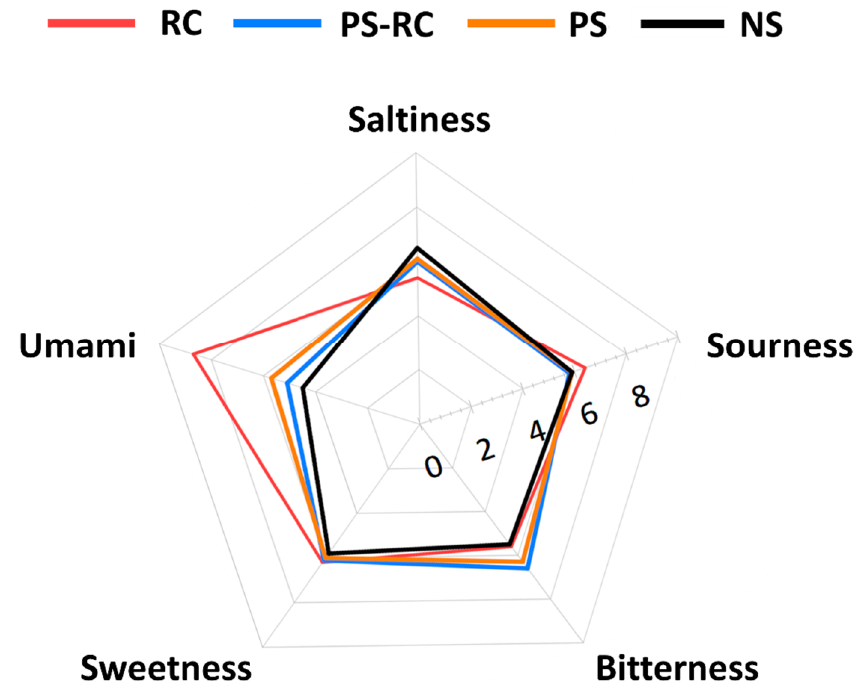
Figure 4. Radar plot for taste data of commercial imitation crab sticks (ICSs) compared to snow crab ( C. opilio ) leg meat (RC). PS-RC, premium ICS with real red snow crab ( C. japonicus ) leg meat; PS, premium ICS without real red snow crab leg meat; NS, normal ICS. Data are shown as means ± standard deviations ( n = 3).